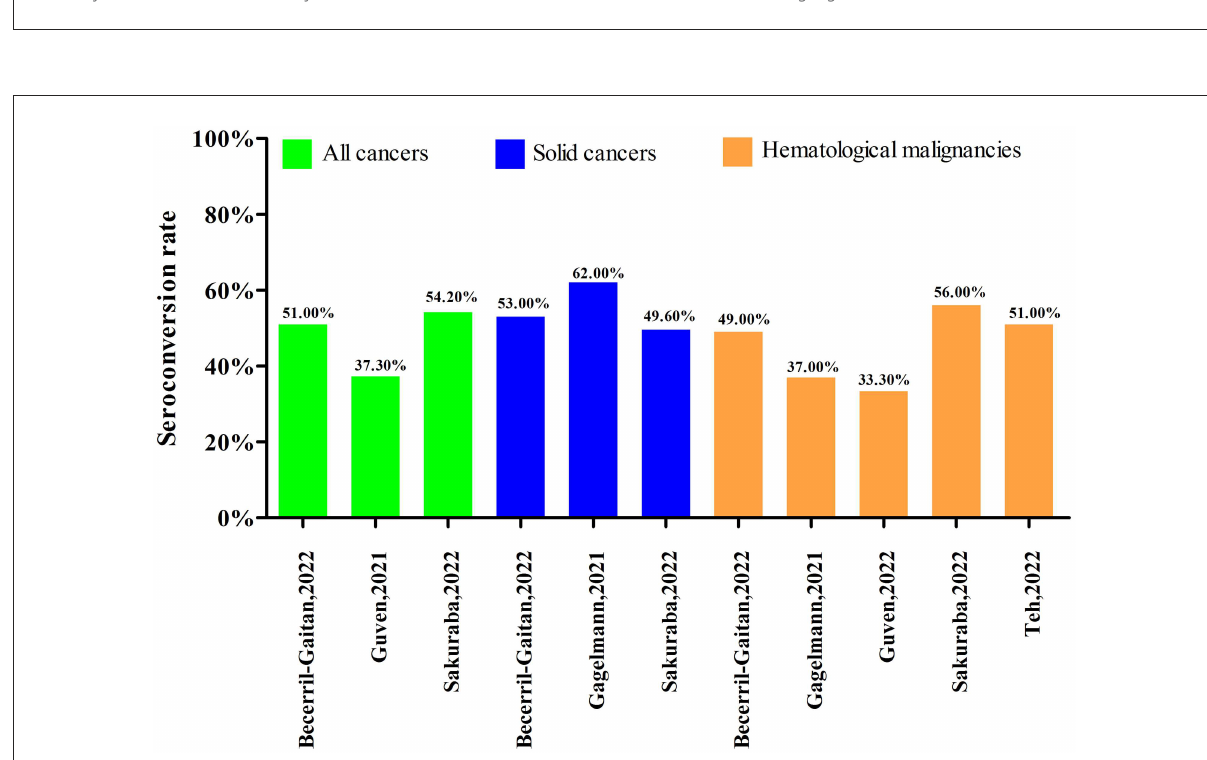
FIGURE3 Quality assessment of included systematic reviews based on AMSTAR-2. Critical domains are highlighted in red.